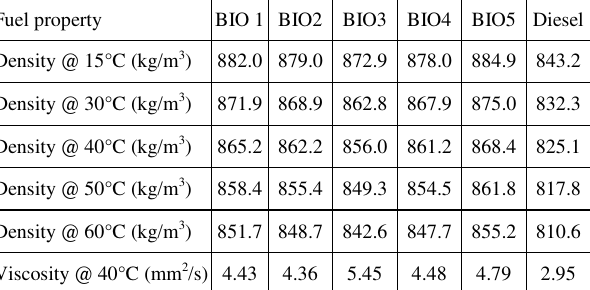
Fig. 1. Schema of test stand used in the experiment